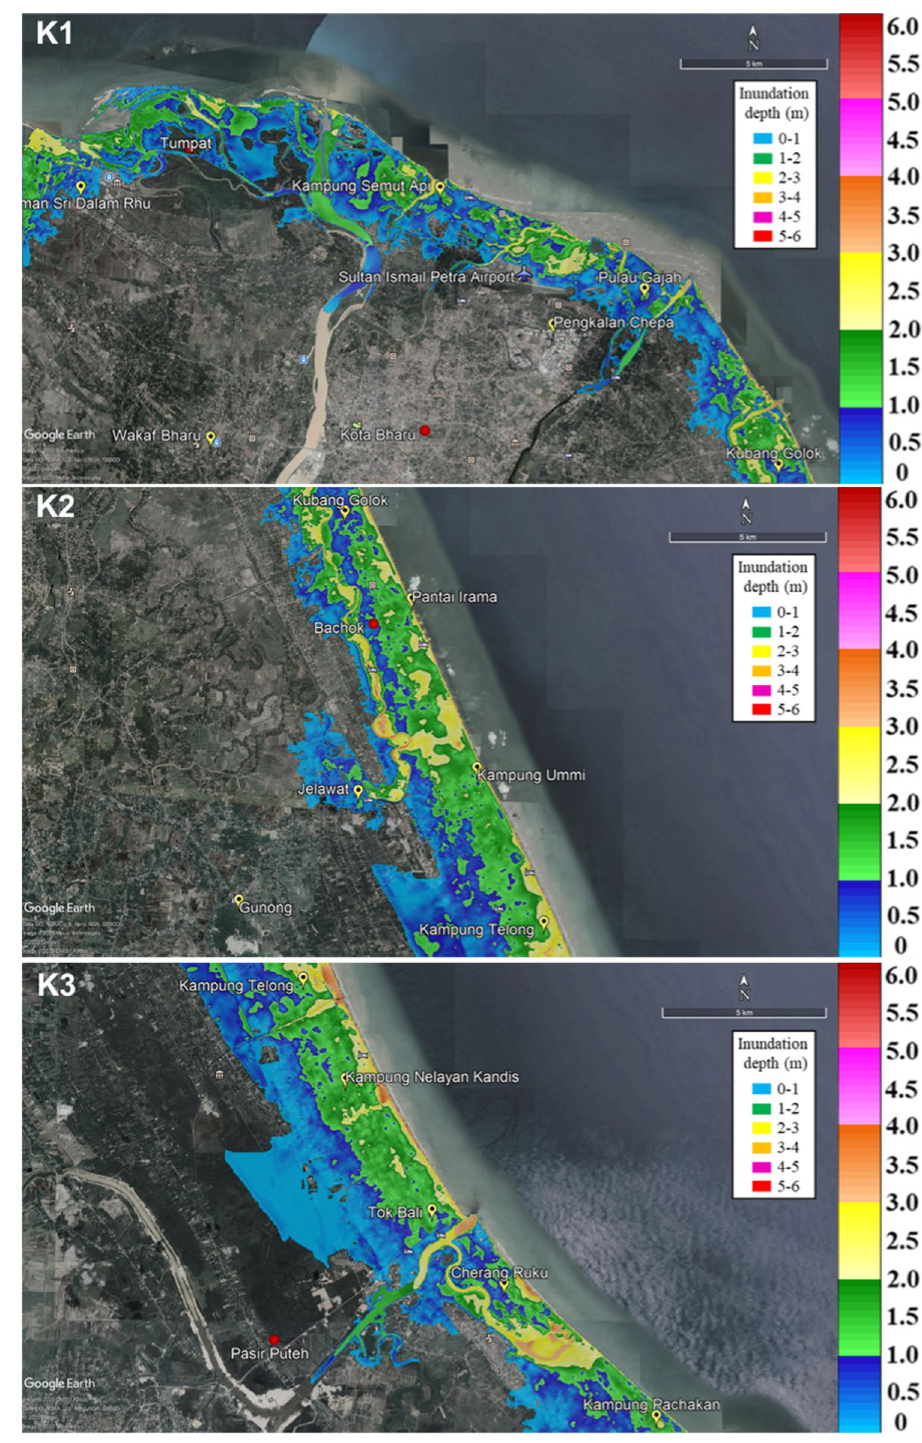
Fig. 6 Inundation map in Kelantan at Mw